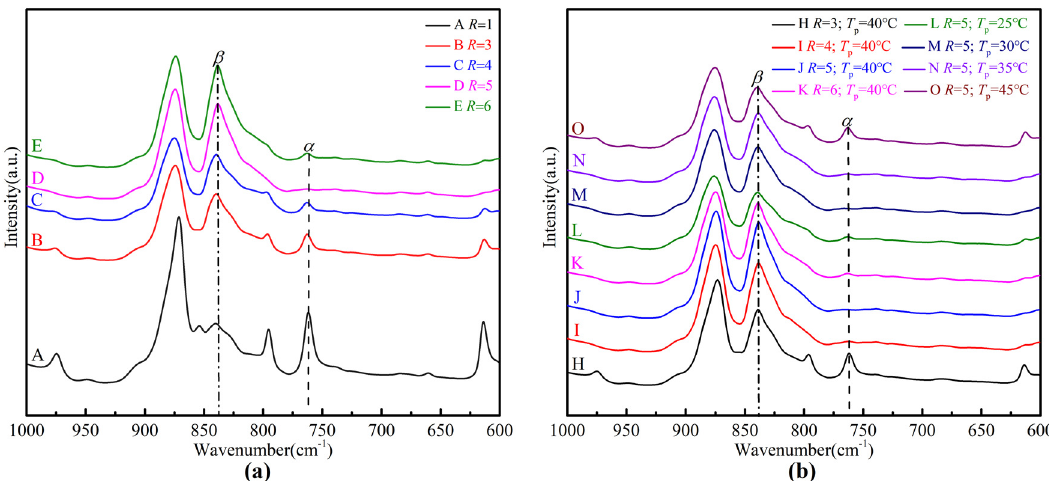
Figure 5: FTIR spectra of PVDF - HFP fi lms: ( a ) stretched PVDF - HFP fi lms at various elongation ratios. ( b ) Stretched and poled PVDF - HFP fi lms at various elongation ratios ( T p = 40°C ) or various poling temperatures ( R = 5 ) .